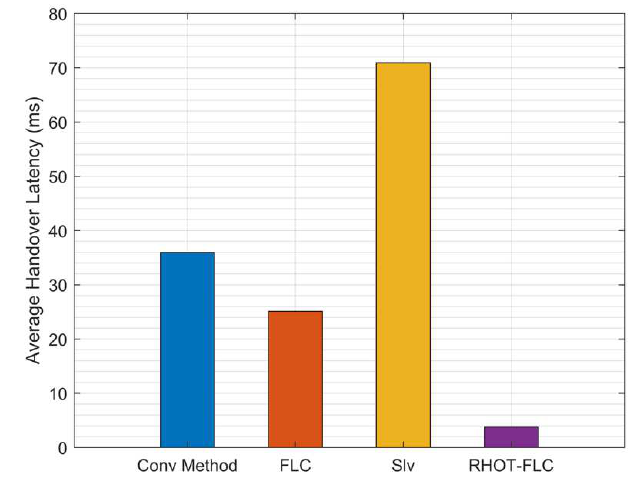
Figure 10. Average HOL overall mobile speeds scenarios.